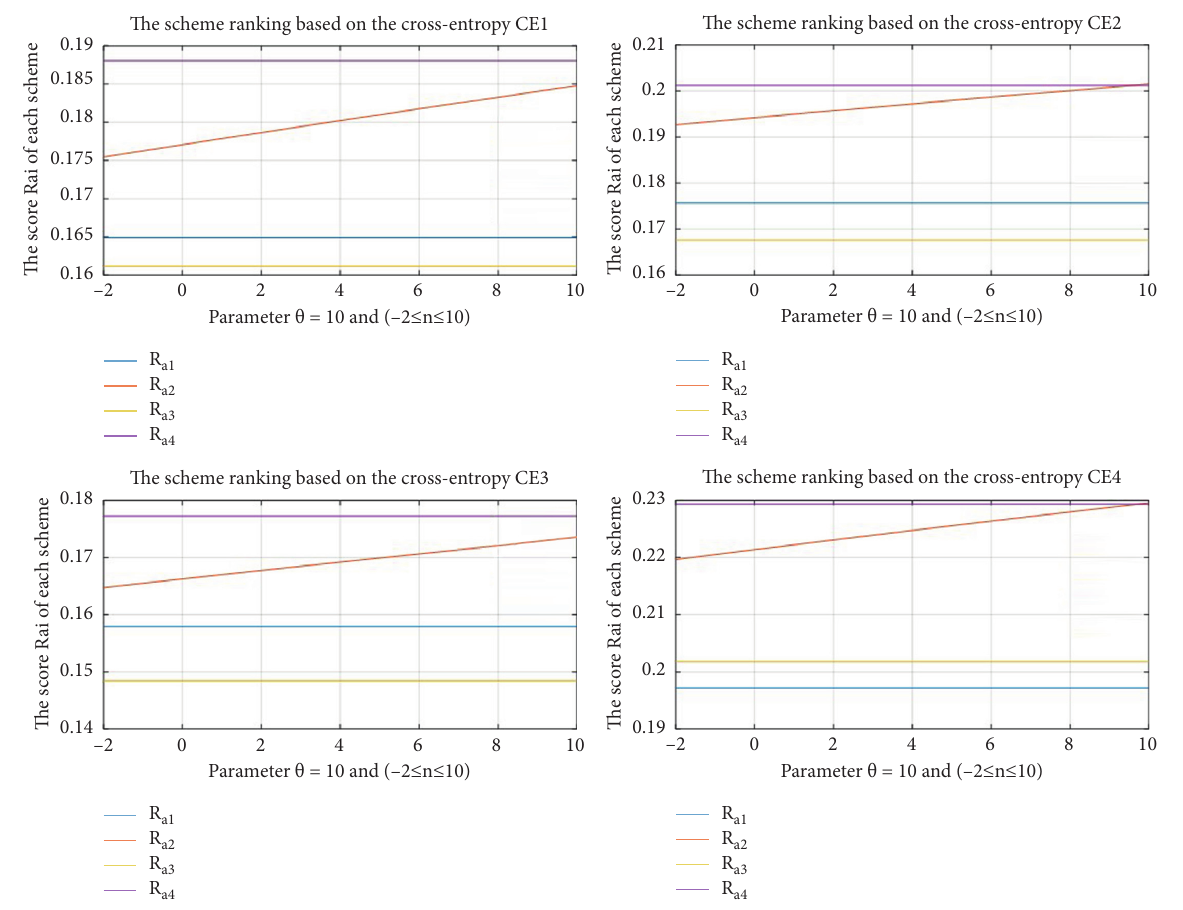
Figure 9: Ranking score of each alternative based on parameters θ � 10, − 2 ≤ n ≤